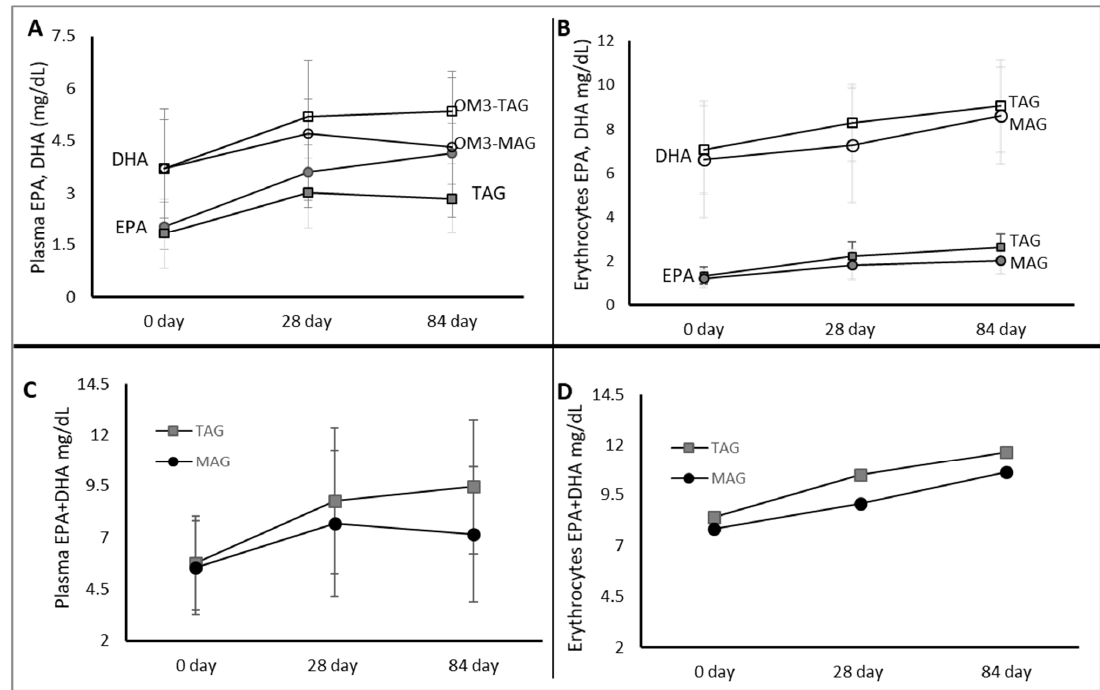
Figure 6. Clinical trial C. Accretion of DHA and EPA at 0, 28, and 84 day in plasma and erythrocytes ( A , B ) after MAG-enriched oil and TAG supplementation. EPA + DHA content per treatment group ( C , D ). Results are expressed in mg/dL).